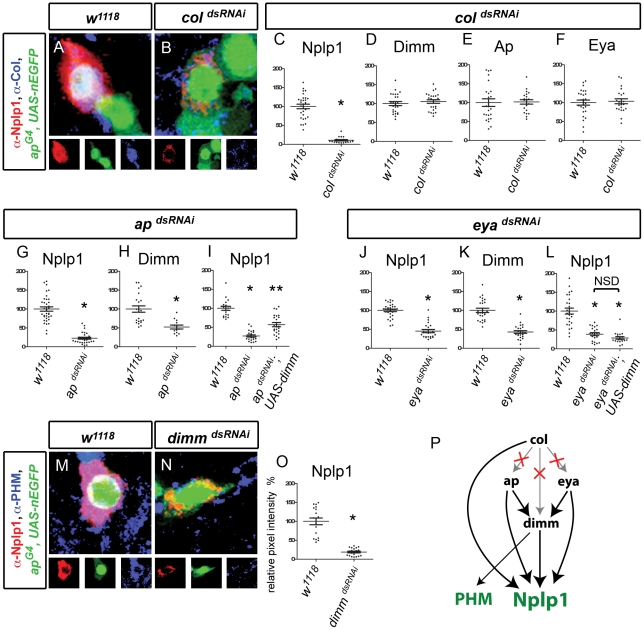
Transcriptional regulation of Nplp1 in adult Tv1 neurons.(A–F) coldsRNAi downregulated Nplp1 but not ap, eya, or dimm in adult Tv1. (A,B) Expression of Nplp1 (red), apGal4,UAS-nEGFP (green) and Col (blue) in adult Tv4 neurons at A10 at 29°C. Col expression is lost and Nplp1 is downregulated in coldsRNAi (B) compared to w1118 control (A). (C) Quantification of Nplp1 immunoreactivity in w1118 (n = 29) and coldsRNAi (n = 20) at A10 at 29°C. (D–F) coldsRNAi did not affect Dimm immunoreactivity (D), apGal4,UAS-nEGFP fluorescence (E) or Eya immunoreactivity (F) compared to w1118 at A10 at 29°C. coldsRNAi (D n = 24; E n = 22; F n = 21). w1118 control (D n = 25; E n = 27; F n = 24). (G–I) apdsRNAi significantly reduced Nplp1 (G) and Dimm (H) immunoreactivity compared to w1118 at A20 at 29°C. (G) * p<0.0001 apdsRNAi (n = 30) compared to w1118 control (n = 36). (H) * p<0.001 apdsRNAi (n = 13) compared to w1118 control (n = 22) (I) Dimm restoration (UAS-dimm) in apdsRNAi background only partially rescued Nplp1 downregulation at A15 at 29°C. * p<0.0001 apdsRNAi (n = 22) compared to w1118 control (n = 19). ** p<0.0001 apdsRNAi;UAS-dimm (n = 23) compared to apdsRNAi and w1118 controls. (J–L) eyadsRNAi significantly reduced Nplp1 (J) and Dimm (K) immunoreactivity compared to w1118 at A10 at 29°C. (L) Dimm restoration (UAS-dimm) in eyadsRNAi background failed to rescue Nplp1 immunoreactivity at A15 at 29°C. * p<0.0001 eyadsRNAi and eyadsRNAi; UAS-dimm (n = 19) compared to w1118 control. NSD, no significant difference between eyadsRNAi and eyadsRNAi;UAS-dimm. eyadsRNAi (J n = 23; K n = 23; L n = 22). w1118 control (J n = 30; K n = 25; L n = 26). (M–O) dimmdsRNAi downregulated Nplp1 and PHM in adult Tv1. (M,N) Tv1 neurons expressing Nplp1 (red), apGal4,UAS-nlsEGFP (green) and PHM (blue) in adult Tv4 neurons at A10 at 29°C. Nplp1 is downregulated and PHM is lost in dimmdsRNAi (n = 18) (M) compared to w1118 control (n = 15) (N). (O) dimmdsRNAi significantly reduced Nplp1 immunoreactivity compared to w1118 at A10 at 29°C. * p<0.0001 dimmdsRNAi (n = 19) compared to w1118 control (n = 18). (P) Model depicting regulation of Nplp1 and PHM and the configuration changes between ap, eya, dimm and col from embryonic to adult Tv1. Notably, col no longer regulates dimm, eya or ap expression (denoted by X). Genotypes: w1118 (UAS-dicer2/+; apGal4/+; tub-Gal80TS, UAS-nEGFP/+); coldsRNAi (UAS-dicer2/+; apGal4/+; tub-Gal80TS, UAS-nEGFP/UAS-coldsRNAi); apdsRNAi (UAS-dicer2/+; apGal4/+; tub-Gal80TS, UAS-nEGFP/UAS-apdsRNAi); apdsRNAi; UAS-dimm (UAS-dicer2/+; apGal4/UAS-dimm; tub-Gal80TS, UAS-nEGFP/UAS-apdsRNAi); eyadsRNAi (UAS-dicer2/UAS-eyadsRNAi; apGal4/+; tub-Gal80TS, UAS-nEGFP/+); eyadsRNAi; UAS-dimm (UAS-dicer2/UAS-eyadsRNAi; apGal4/UAS-dimm; tub-Gal80TS, UAS-nEGFP/+); dimmdsRNAi (UAS-dicer2/+; apGal4/UAS-eyadsRNAi; tub-Gal80TS, UAS-nEGFP/+); rev4,dimmdsRNAi (UAS-dicer2/+; apGal4/rev4, UAS-dimmdsRNAi; tub-Gal80TS, UAS-nEGFP/+).